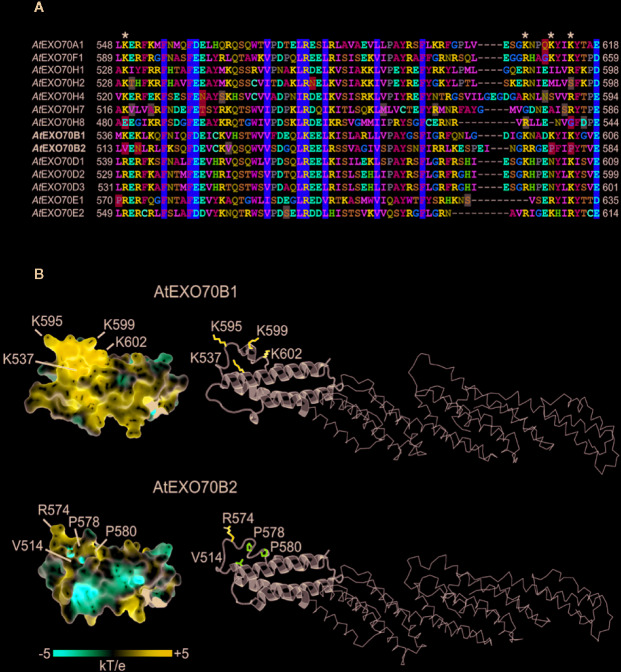
Alignment of predicted lipid-interacting motifs of selected EXO70 paralogs (A) and 3D structures of C termini of EXO70B1 and EXO70B2 (B). Residues shown on yellow background are conserved in all isoforms; positions with basic and acidic residues were found to be conserved as well (blue and red letters, respectively); a pair of prolins and valine replacing basic amino acids in the putative binding motif was found in EXO70B2 but not in EXO70B1; several conserved glutamate/aspartate residues are replaced by an asparagine residue in some of EXO70H isoforms (blue boxes; A). The visualization of electrostatic potential of EXO70B1 C-terminal domain revealed positively charged pocket containing three lysine residues that are mutated in EXO70B2, resulting in significant loss of positive charge (B).